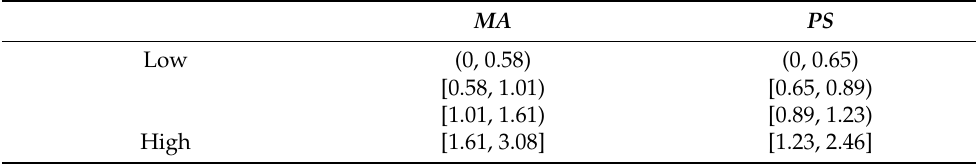
Table 3. Industrial agglomeration